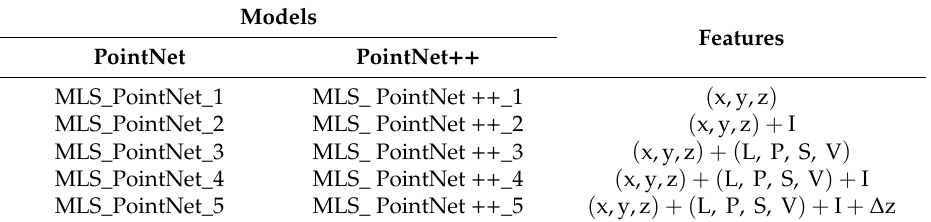
Table 7. PointNet and PointNet ++ models with di ff erent features for MLS point cloud classification. Models